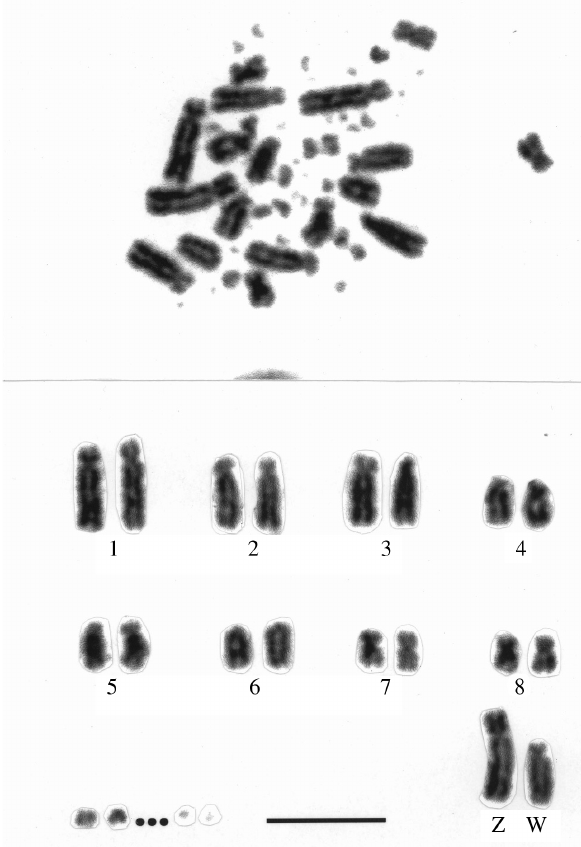
Figure 2 - Conventionally stained mitotic metaphase and female karyotype showing the macrochromosomes and the first and last pairs of microchromosomes of Graydidascalus brachyurus . Bar = 10 µ